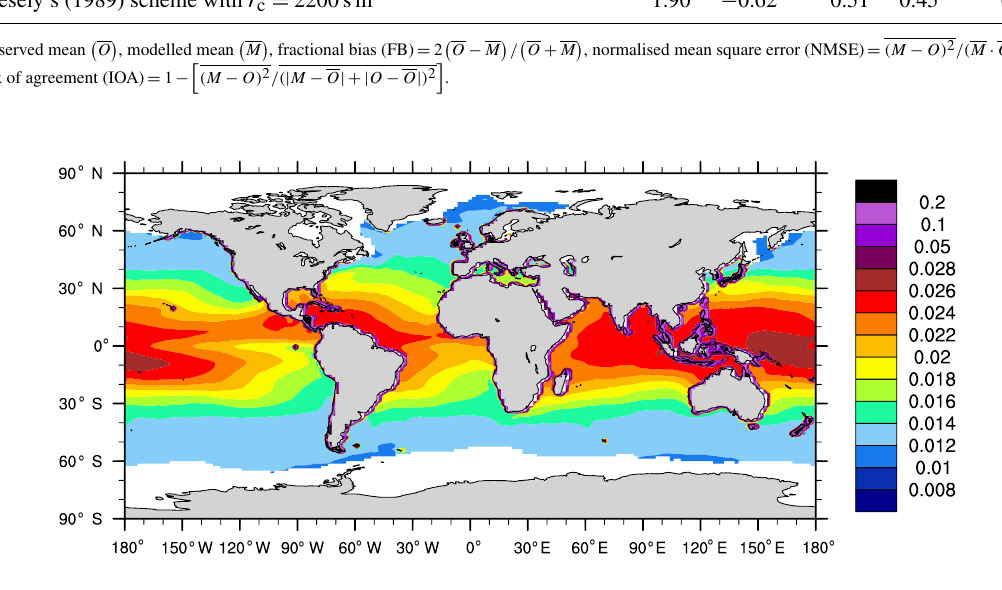
Table 1. Performance statistics of various ozone dry deposition velocity schemes for seawater compared to the observations plotted in Fig. 7 ∗ . Scheme M/O FB NMSE IOA Ranking Present two-layer scheme 0.99 0.01 0.06 0.92 1 Present two-layer scheme with the Chance et al. (2014) [ I − ] 1.20 − 0.19 0.09 0.88 2 Present two-layer scheme with DOC also included 1.30 − 0.26 0.14 0.73 4 One-layer scheme of Fairall et al. (2007) 1.63 One-layer scheme of Fairall et al. (2007) without waterside turbulence 0.73 Wesely’s (1989) scheme with r c = 2200sm − 1 1.90 6